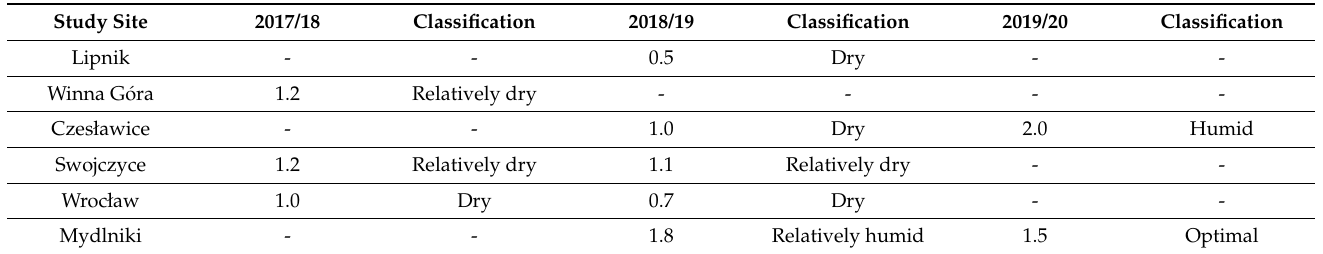
Table 3. Hydrothermal coefficient (K) calculated for the study sites for the seasons 2017/18, 2018/19 and